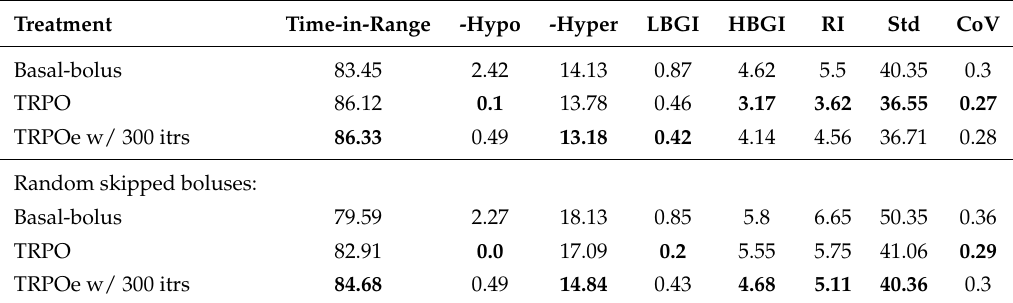
Table 1. Summary of basal-bolus, TRPO and TRPOe results for the Hovorka patient. low blood glucose indices (LBGI) and high blood glucose indices (HBGI) is low and high blood glucose index respectively, RI is risk index, Std is the overall standard deviation and CoV is the coefficient of variation. All 100 test meal scenarios are included in the performance measures. A lower score is better for all measures, except